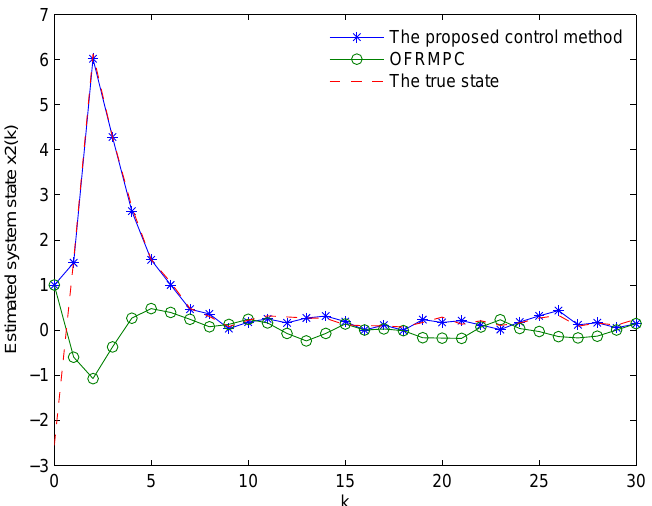
Figure 2. The system state x2 and estimated state for the proposed method and OFRMPC method.